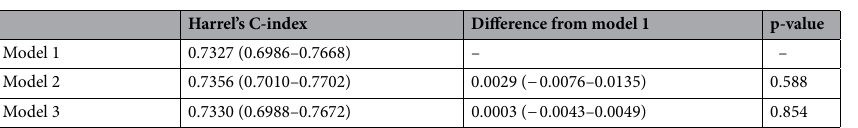
Table 3. Comparison of the discrimination of prediction for the progression of CKD between targeted BP, PP, and the combination of PP and targeted BP. Model 1: conventional targeted BP (< 130/80 mmHg for those with diabetes or proteinuria and < 140/90 mmHg); model 2: PP ≥ 66 mmHg; model 3: combination of PP (< 66 or ≥ 66) and/or targeted BP. Other variables for adjustment were age, sex, BP-lowering medication, diabetes, dyslipidemia, hyperuricemia, obesity, smoking, drinking, and baseline eGFR and